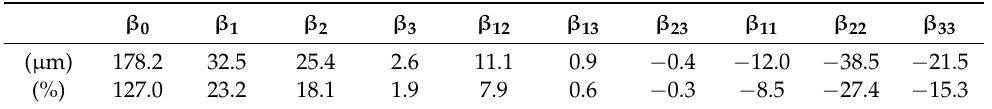
Table 4. Regression coefficients for the coating thickness response considering x 1 , x 2 , x 3 (in codified units) and f out in µ m and percentage over the mean thickness value.